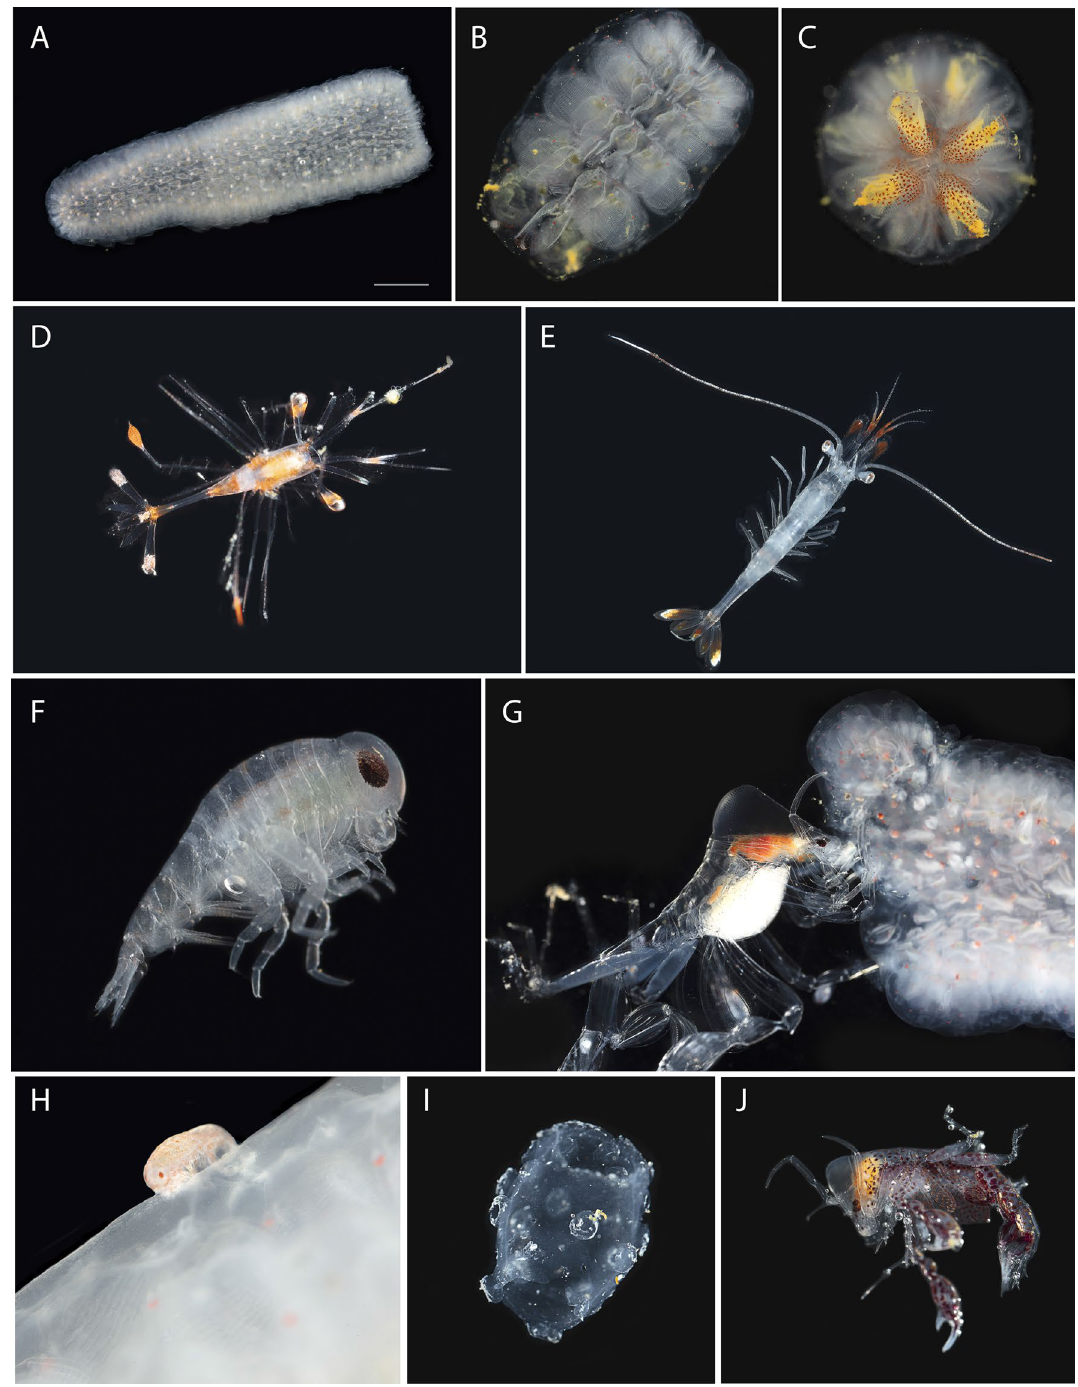
Figure 5. Macro photographs of live animals on board R/V Poseidon . ( A – C ) P. atlanticum , scale bar 1 cm. Individual zooids visible in B and C, colonies respectively ~ 1 cm in length and < 3 mm in diameter. ( D , E ) Early (< 1 cm) and late (> 2 cm) juvenile Funchalia villosa collected from P. atlanticum . ( F ) Unknown juvenile oxycephalid collected off P. atlanticum, body length < 2 mm. ( G ) Phronima specimen feeding on P. atlanticum colony overnight and undeterred by the camera strobes. ( H ) Unknown juvenile oxycephalid still attached to P. atlanticum , body length < 1 mm. ( I – J ) Phronima -modified barrel made from a P. atlanticum colony that was inhabited by the individual in J, barrel was just under 2 cm in